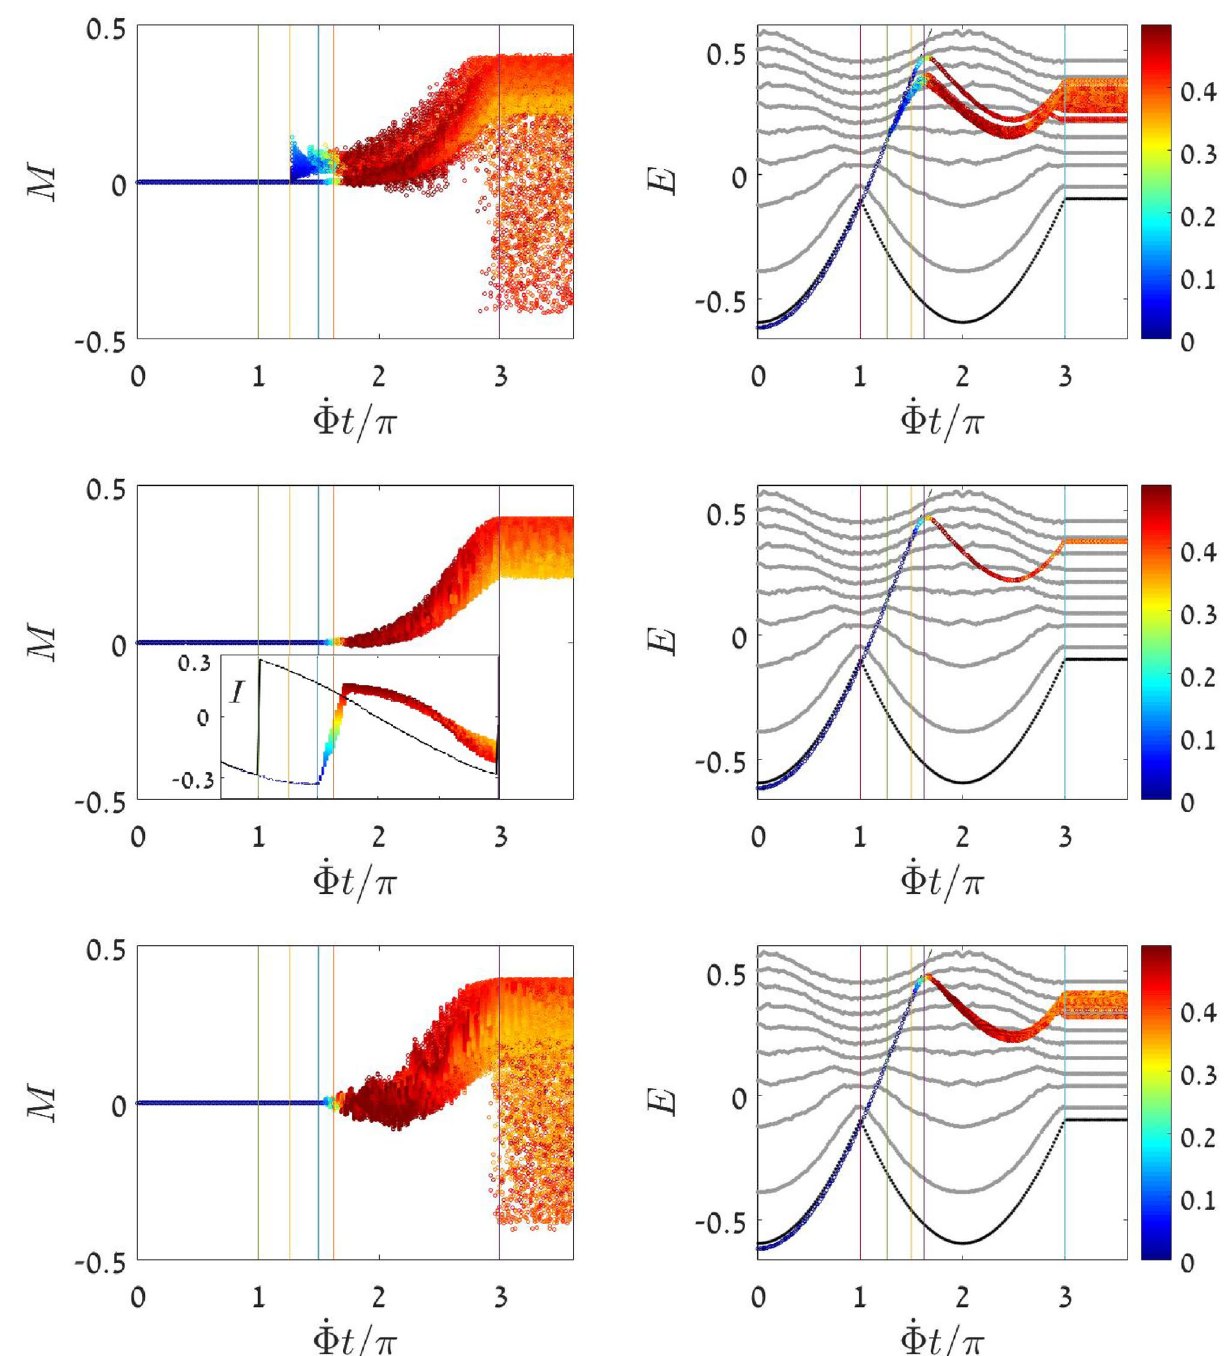
Figure 2. Semiclassical simulation of a sweep process. Here and below we consider a 3-site ring. The initial 0.0001 at n 0 . Left : The ( n , M ) coordinates of the evolving condensate is represented by a cloud of radius R = = n / N , M M / N ). The trajectories are presented as a function of time. Both coordinates are normalized ( n := := 0 and red to total depletion. Right : The energy E of n values are color coded such that blue corresponds to n = the evolving points as function of time. The dotted line is the ground state energy E GS , and the dashed line is the condensate energy E 0 . The other lines in the background are subset of adiabatic E n curves (see text). Inset 2.3 , (second row): The current I that flows in the ring as a function of time. Parameters : The interaction is u = π and � stb ( 3 / 2 )π and 1.26 π and � dyn and the associated vertical lines are from left to right � mts = = = � swp 1.62 π . The units of time have been chosen such that K 1 . Each row is for a different sweep rate. From = = � � 3 π 10 − 4 (slow) and 5 π 10 − 4 (optimal) and 3 π 10 − 3 up to down we have ˙ � ˙ ˙ = · = · = ·